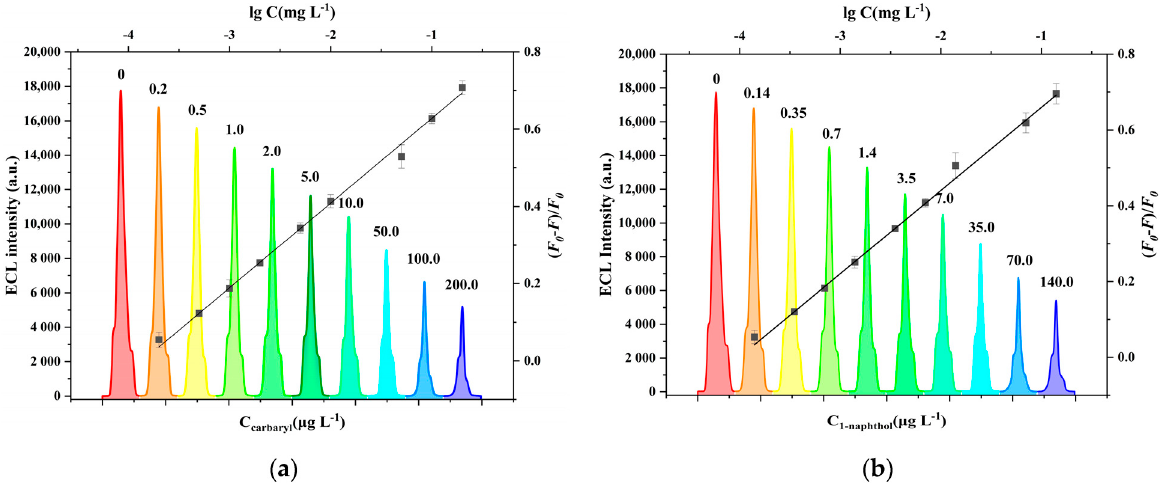
Figure 3. ( a ) ECL curves of a series concentration of carbaryl (0.2, 0.5, 1.0, 2.0, 5.0, 10.0, 50.0, 100.0, and 200.0 μ g L − 1 ) detected by Eu 3+ -MOF-253@Au sensor, and the calibration curve for carbaryl detection; ( b ) ECL curves of a series concentration of 1-naphthol (0.14, 0.35, 0.7, 1.4, 3.5, 7.0, 35.0, 70.0, and 140.0 μ g L − 1 ) detected by Eu 3+ -MOF-253@Au sensor, and the calibration curve for 1- naphthol detection.